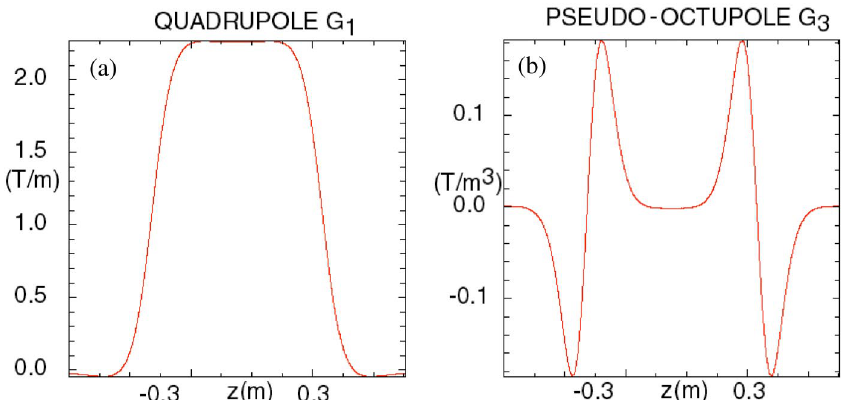
FIG. 16. (Color) Dominant (a) quadrupole and (b) pseudo-octupole coefficients for the multipole decomposition B ? (cid:9) r; "; z (cid:10) (cid:3) (cid:9) z (cid:10) r cos (cid:9) 2 " (cid:10) (cid:1) G (cid:9) z (cid:10) r 3 cos (cid:9) 2 " (cid:10) (cid:1) (cid:18) (cid:18) (cid:18) G 1 3